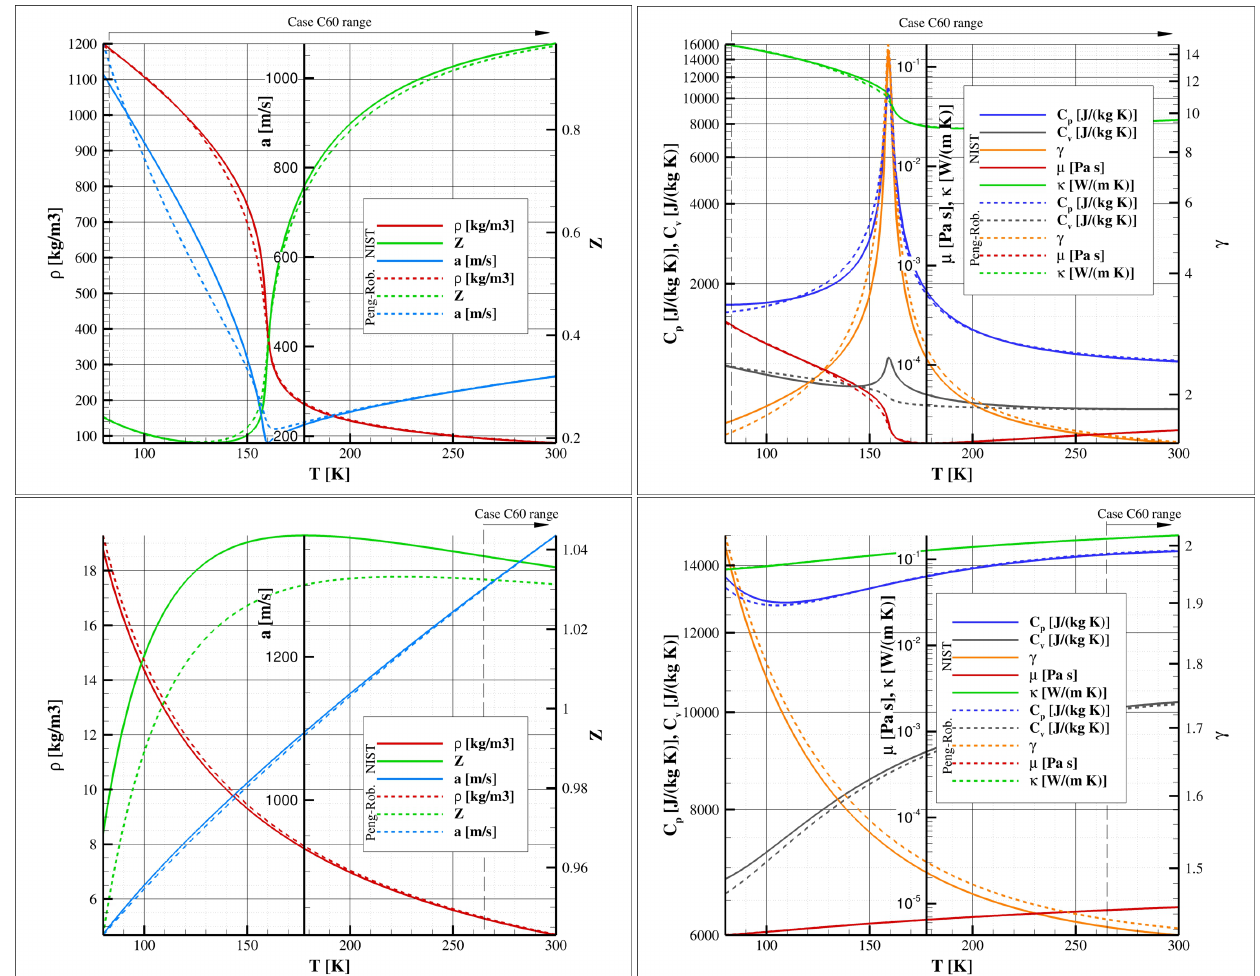
Figure 7. Comparison of some real gas properties estimated through the translated volume Peng– Robinson EoS and NIST reference data for O 2 ( top ) and H 2 ( bottom ) at 60 bar as in the MASCOTTE C-60 test case: density ρ , sound speed a, compressibility factor Z, specific heat ratio γ = C p / C v , viscosity µ , thermal conductivity κ